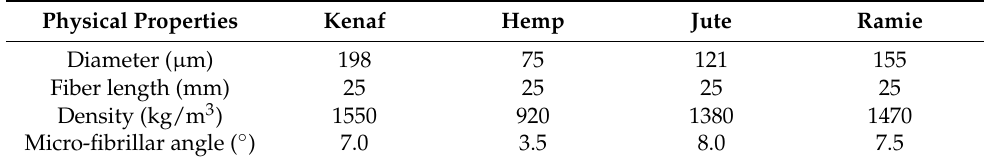
Table 4. Physical properties of natural lignocellulosic fibers.